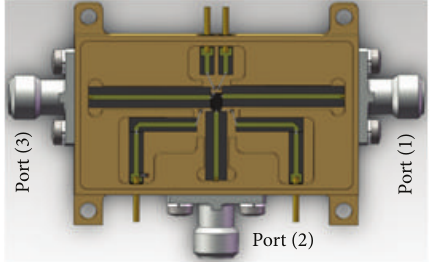
Figure 6: The designed test fixture for the proposed MFPA.